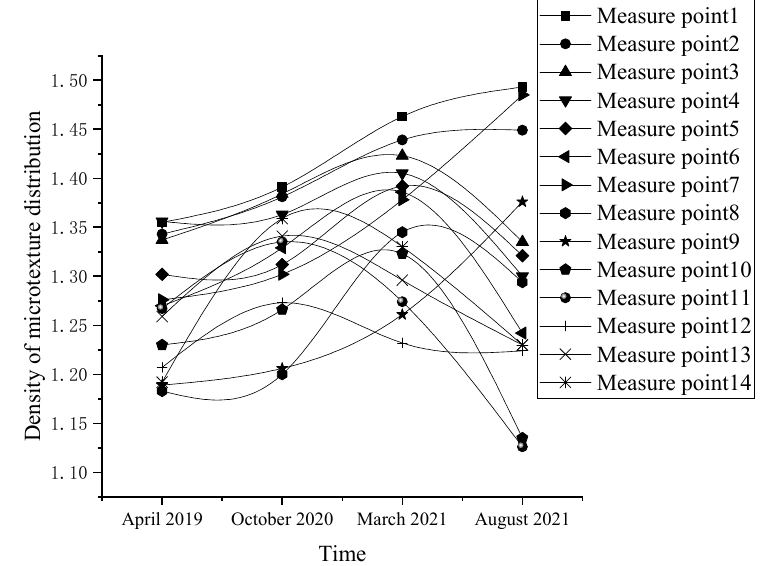
Figure 17. Microtexture distribution density detection results.